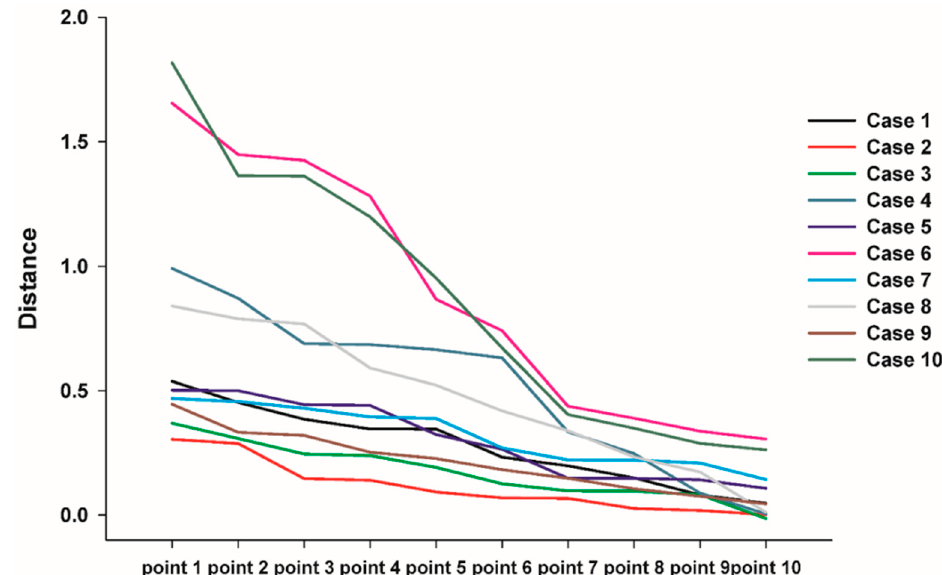
Figure 5. Linear mixed-effects model (LMEM) also showed significant differences between cases (F(9, 16.76) = 6.095, p = 0.001).